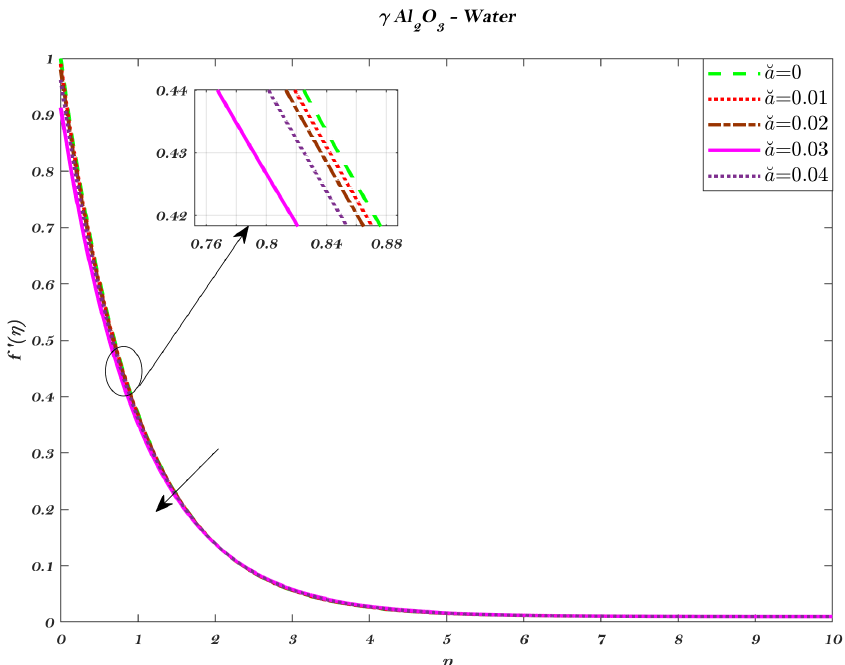
Figure 10. The influence of the slip parameter ˘ a against η on the velocity profile with ϕ = 3%, (cid:101) = 0.01 and R = 1.